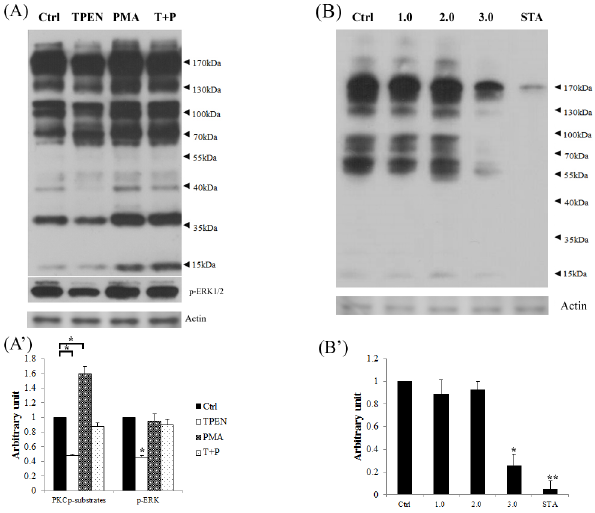
Figure 6. TPEN inhibits phosphorylation of PKC substrates in porcine oocytes. (A) TPEN downregulates phosphorylation of PKC substrates and MAPK in porcine oocytes, while PMA increases the phosphorylation of these proteins, even in the presence of TPEN. The density of band were digitalized. Oocytes were treated with TPEN, PMA, or TPEN plus PMA (T + P). A sample containing 400 oocytes was loaded per lane. ( B ) Oocytes were treated with various concentrations of TPEN (0, 0.1, 1.0, and 3.0 m M) or staurosporine (STA). Phosphorylation of PKC substrates was examined after 25 h of IVM. A sample containing 200 oocytes was loaded per lane. (A 9 ) and (B 9 ) Western blots were analyzed using Gel-pro software. The IOD of each treatment group was normalized against that of the control group. Ctrl, control group. Data are expressed as mean values 6 SEM of three independent experiments. *, P , 0.05; **, P , 0.01.